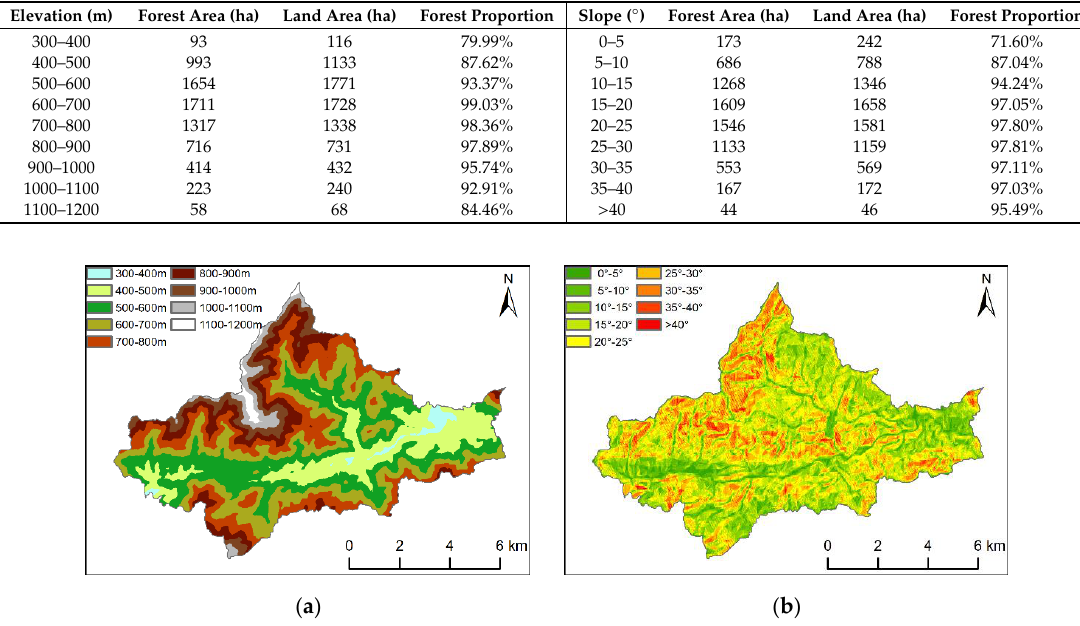
Figure 6. ( a ) Spatial distribution of different elevation zones in Chebaling; ( b ) spatial distribution of different slope zones in Chebaling.